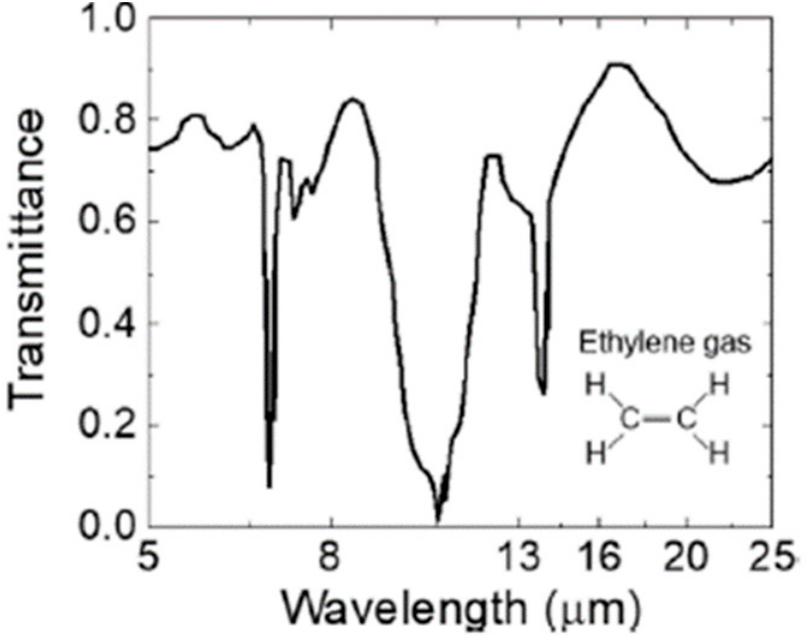
Figure 12. The slab of selectively infrared emitting ethylene gases [83].